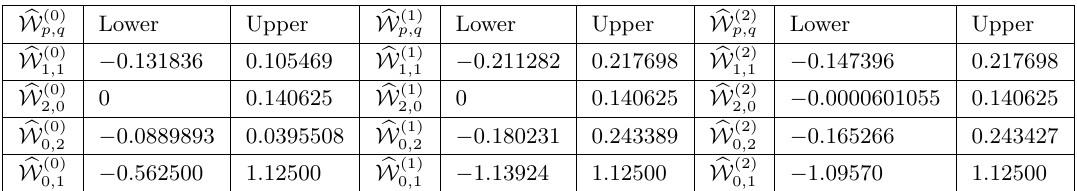
Table 1 . Bounds on c W ( k ) p,q for n = 2 in equation (4.14). We use the normalizations c W ( k ) normalization can be restored via replacing c W ( k )